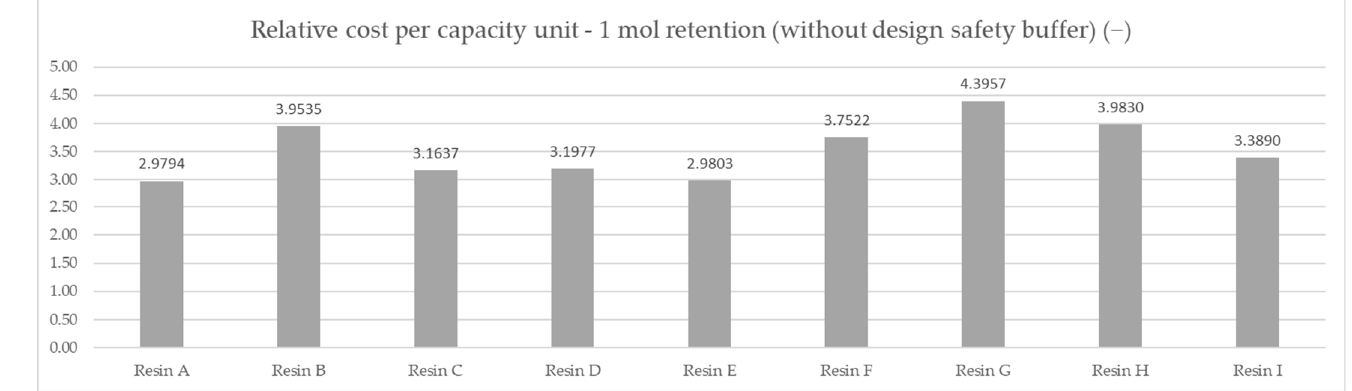
Figure 9. Comparison of the relative cost of calculated average mmol capacity unit—DAP price for 1 mol capacity for the set testing conditions.